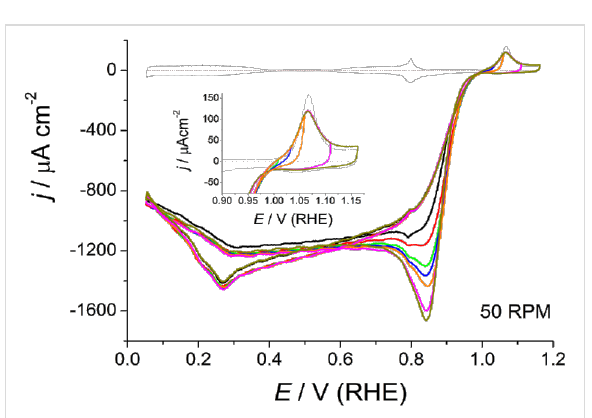
Figure 8: Cyclic voltammograms in the high potential region for the ORR on a HMRD Pt(111) electrode in oxygen saturated 0.1 M HClO 4 , at different upper potentials and 50 rpm. Inset: Detailed view of the Pt(111) oxide formation region.